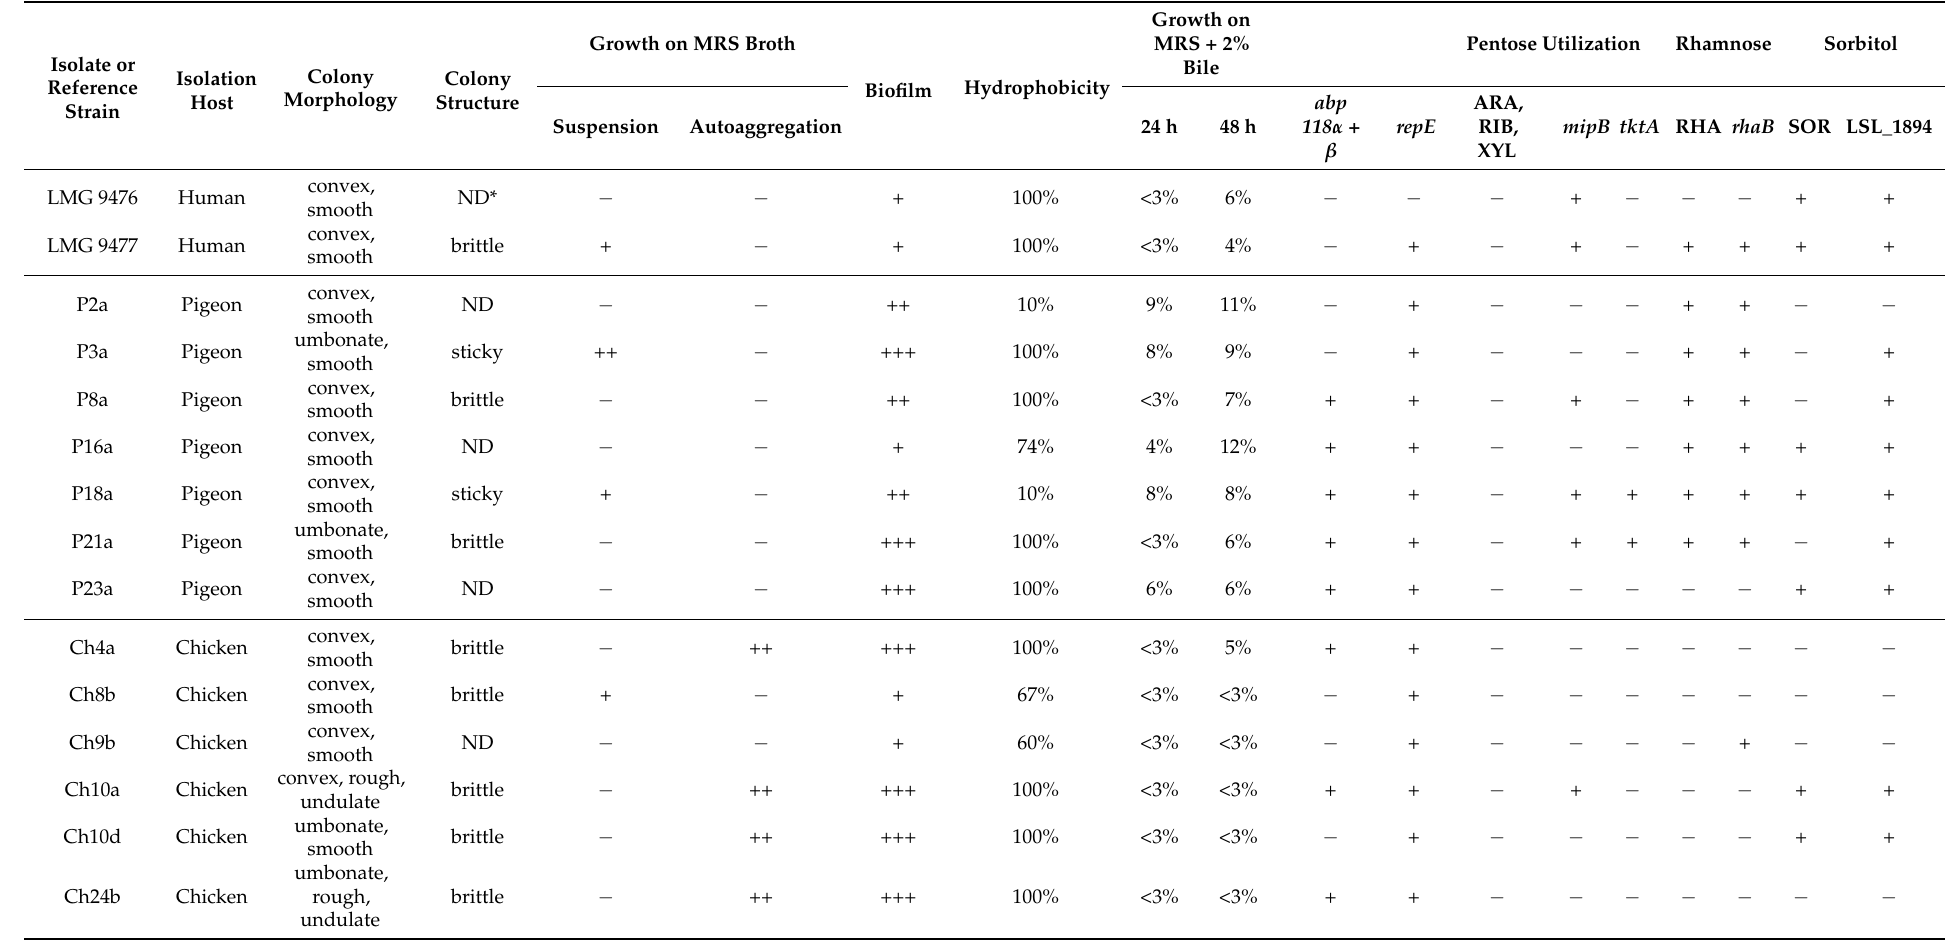
Table 2. L. salivarius strains used in this study and their colony morphology, broth growth characteristics, biofilm formation capacity, hydrophobicity and tolerance to 2% bile; capability of the strains to utilize arabinose (ARA), ribose (RIB) and xylose (XYL), rhamnose (RHA) and sorbitol (SOR). Distribution of the repE , bacteriocin Abp118 genes and genes related to sugar metabolism ( mipB , tktA , rhaB and LSL_1894). ND*—the structure of the colonies was not determined as they were neither clearly brittle nor clearly sticky; the meaning of the signs “ − ”, “+”, “++” and “+++” are explained in the Section